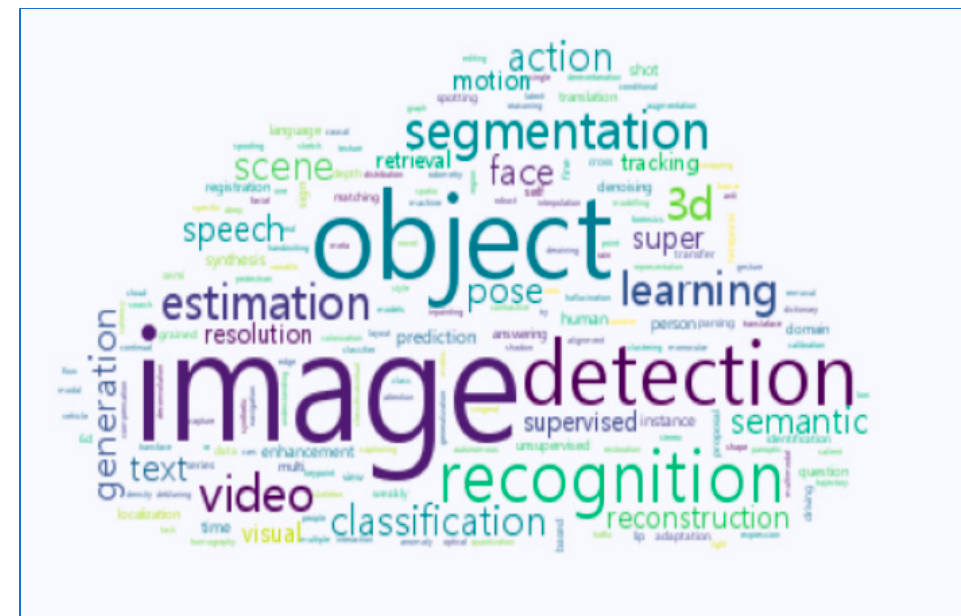
Figure 5. Main keyword word-cloud.